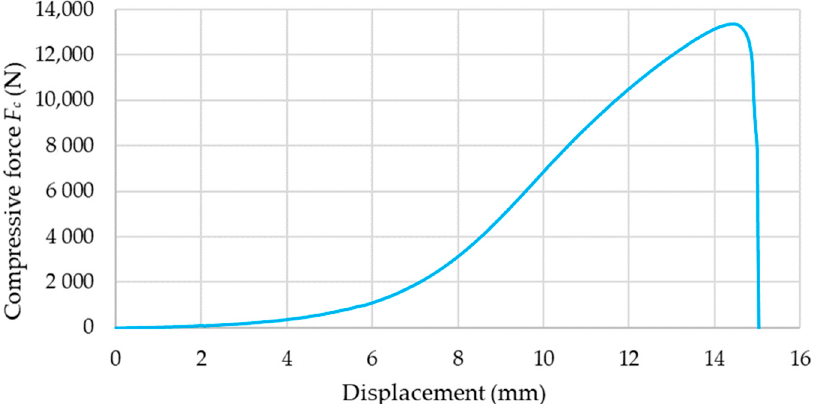
Figure 11. Characteristic curve of the variance in the compressive force F c of the oak sawdust sample obtained under compaction with a force F = 34,000 N.